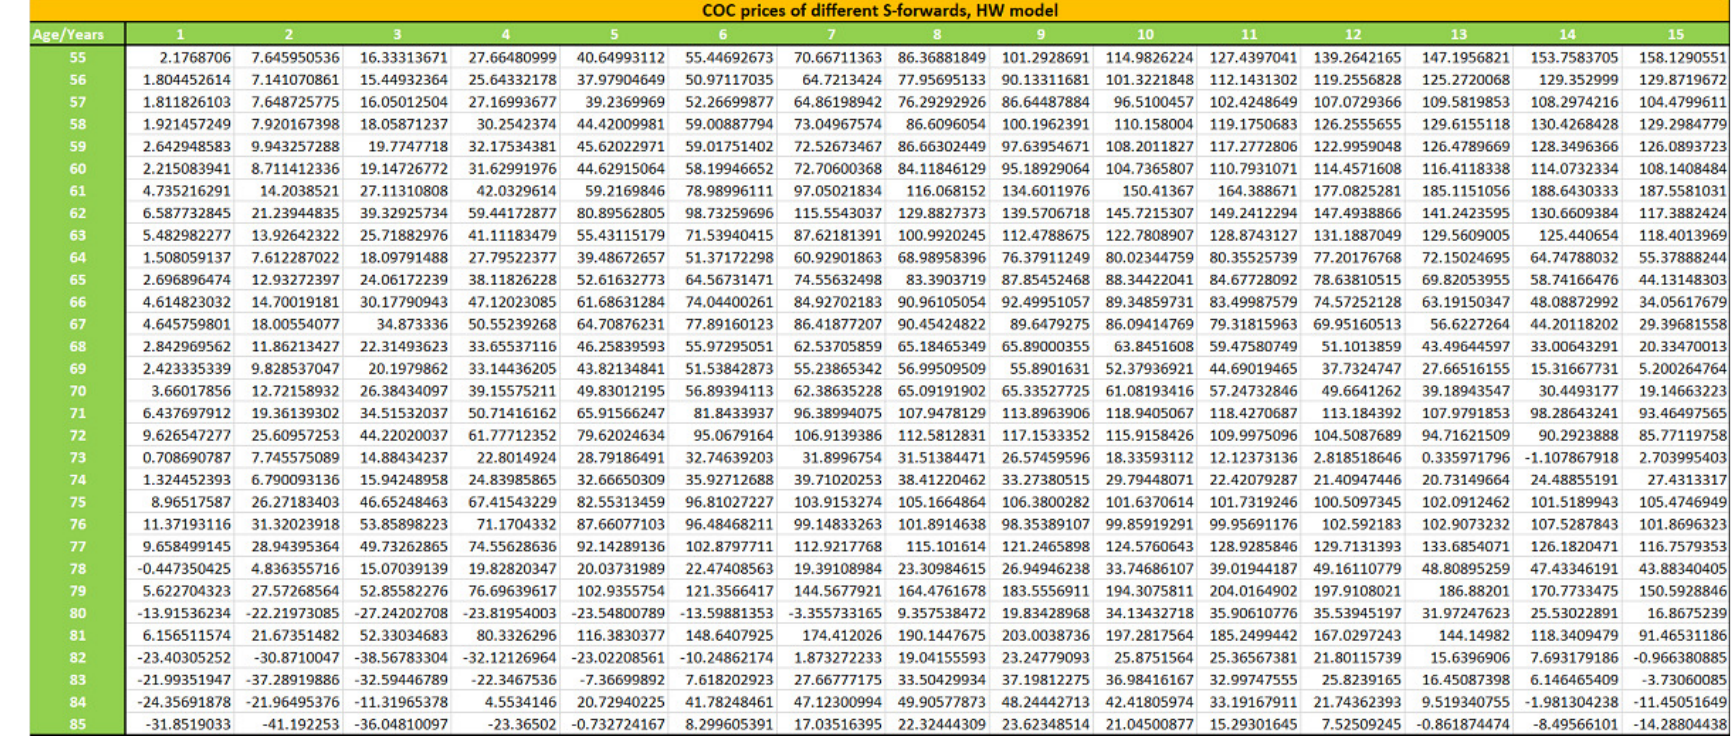
Figure A1. Prices of S-forward prices under the Cost of Capital approach, HW